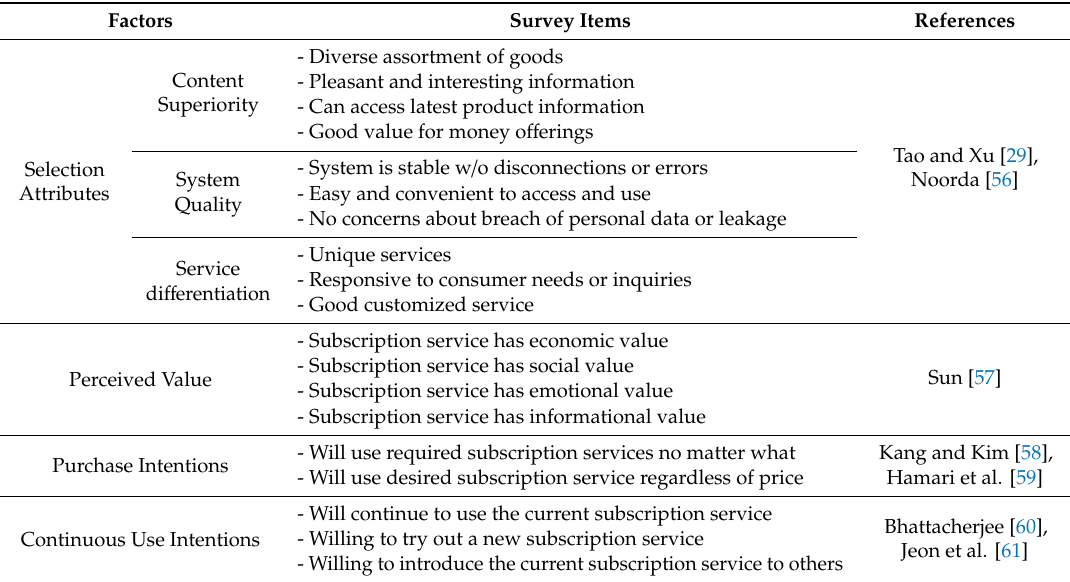
Table 1. Variable